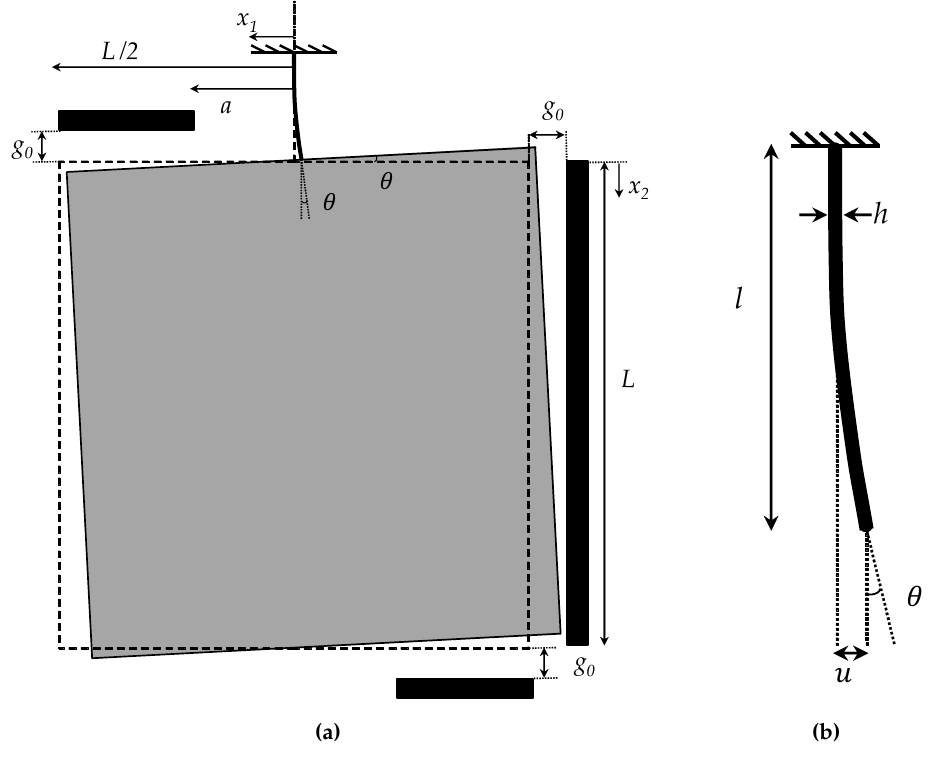
Figure 4. ( a ) Schematic of the behavior of the whole test structure in the case of lateral actuation and ( b ) close-up of the deflected